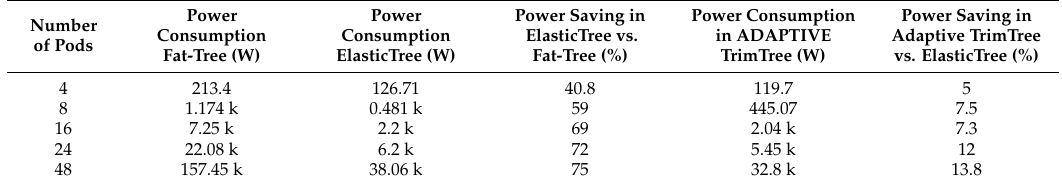
Table 4. Power saving in Adaptive TrimTree.